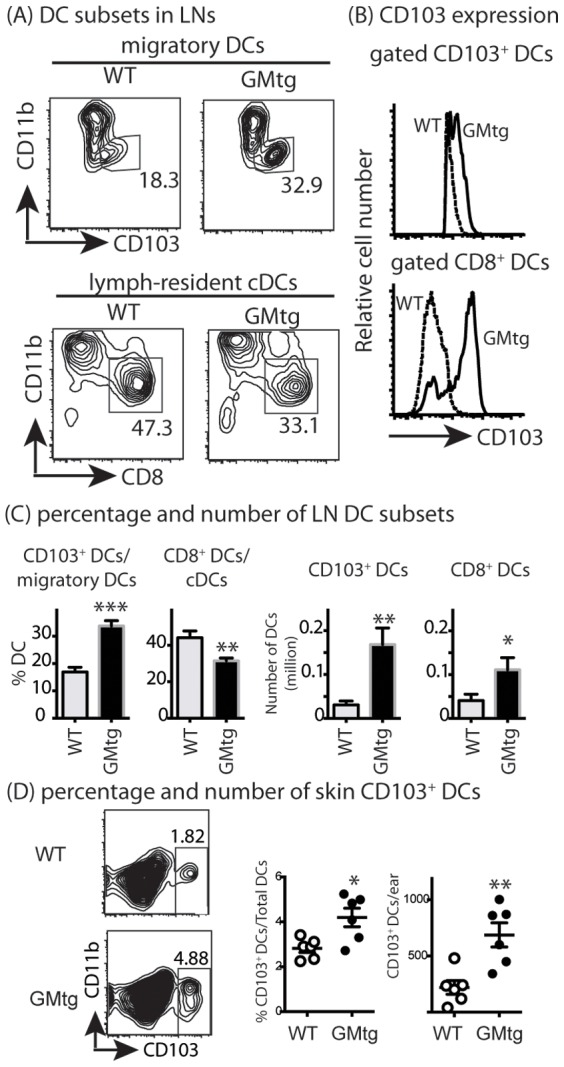
Elevated GM-CSF increase CD103+ DCs.DC-enriched LN cells were isolated from pooled LN for individual GMtg mice and wild type littermates. DC-enriched LN cells were stained for cell surface markers. (A) Gated CD11c+ cells were segregated into migratory DC (MHC class IIhi and CD11cint) and lymphoid-resident DC (MHC class IIint and CD11chi) fractions. Numbers inside dot plots indicate percentage of gated populations. (B) CD103 expression by CD103+ DCs and CD8+ DCs is shown. (C) Mean numbers of DC subsets from cutaneous LNs of individual mice in each group are shown in bar graphs. Data are representative of >3 experiments. (D) Number of CD103+ DCs in ear skin. Each dot represents the data derived from an individual mouse. Horizontal line shows the mean ± SEM. Data are pooled from two experiments (*P<0.05, **P<0.01; Two tailed Student's T test).